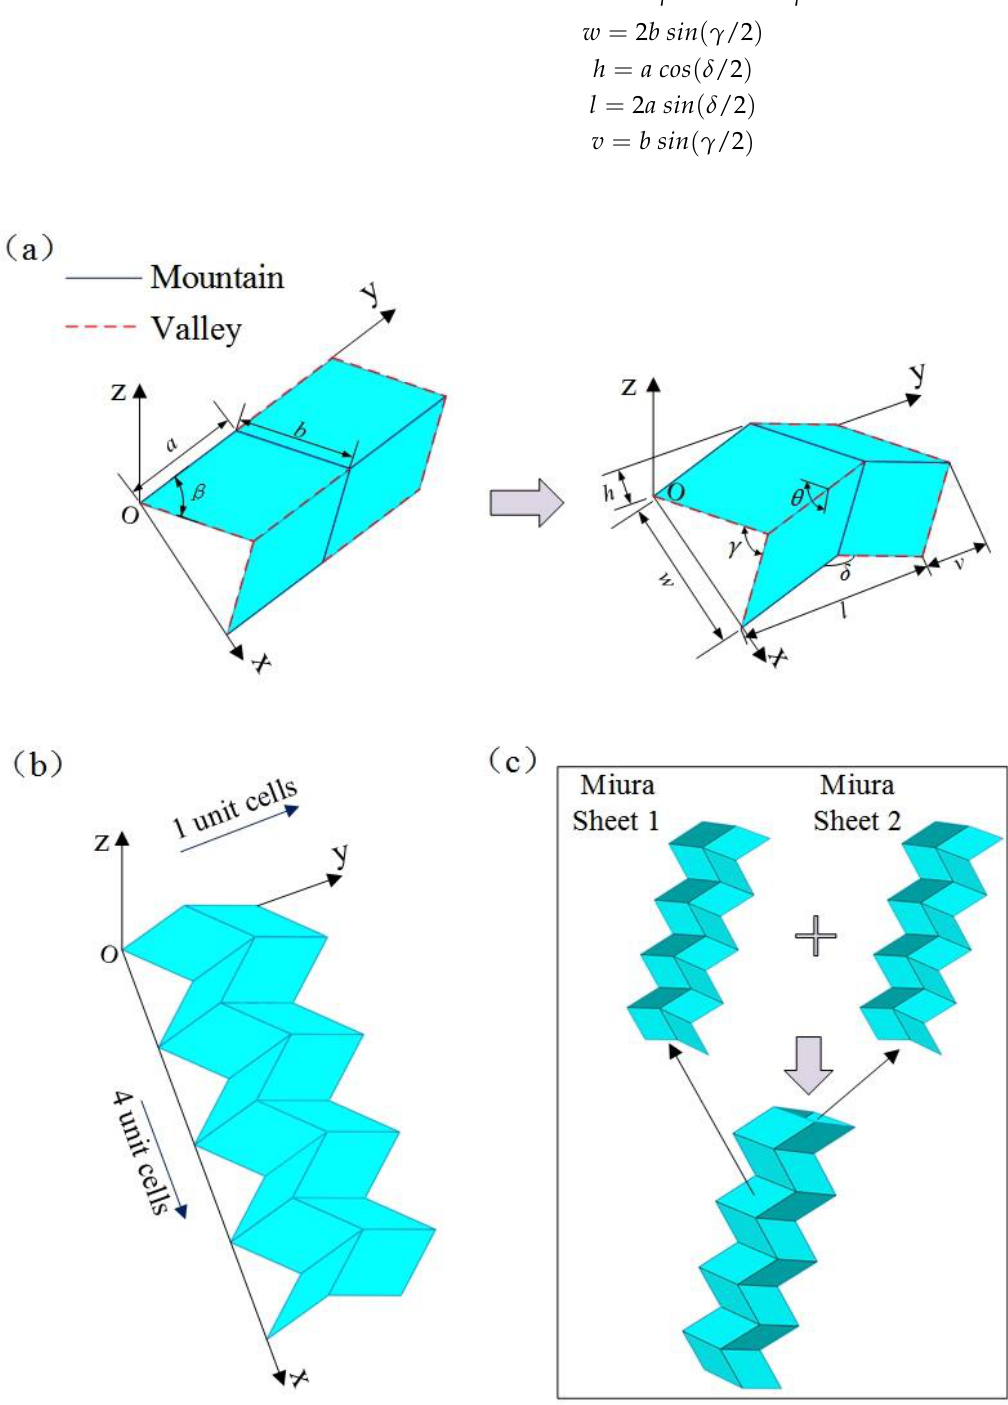
Figure 1. Construction of a Miura tube model: ( a ) geometric model of Miura sheet unit, ( b ) geometric model of a Miura sheet (consisting of four Miura sheet units), and ( c ) geometrical model of a Miura tube (consisting of two identical Miura